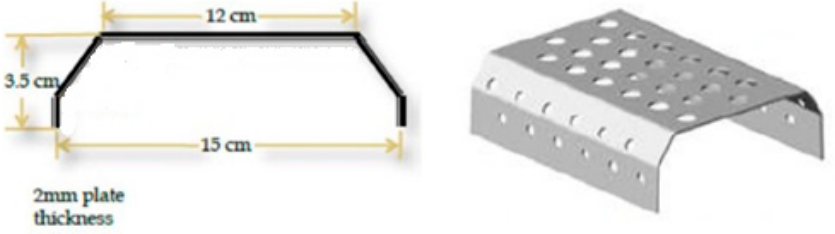
Figure 3. Technical drawings of the MA insert.